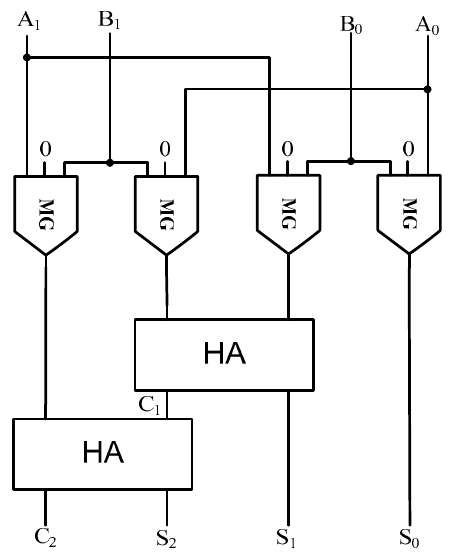
Figure 6. The method of the two-bit Vedic multiplier.